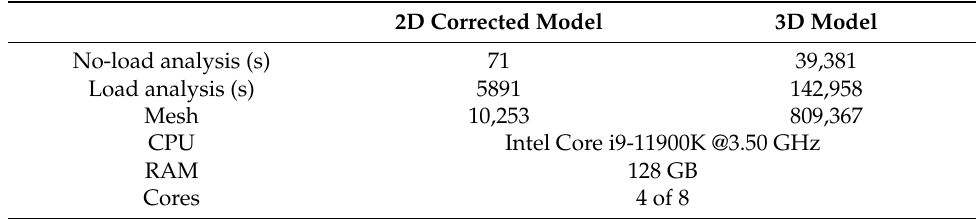
Table 6. Analysis